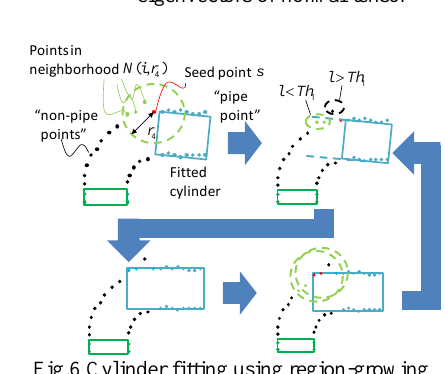
Fig.5 Normal gauss image and